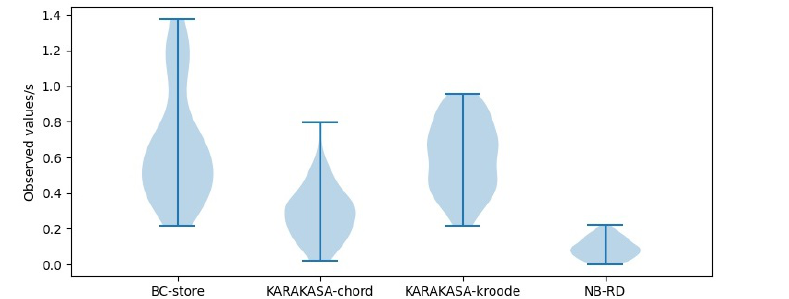
Figure 12. Availability performance in node = 1000.